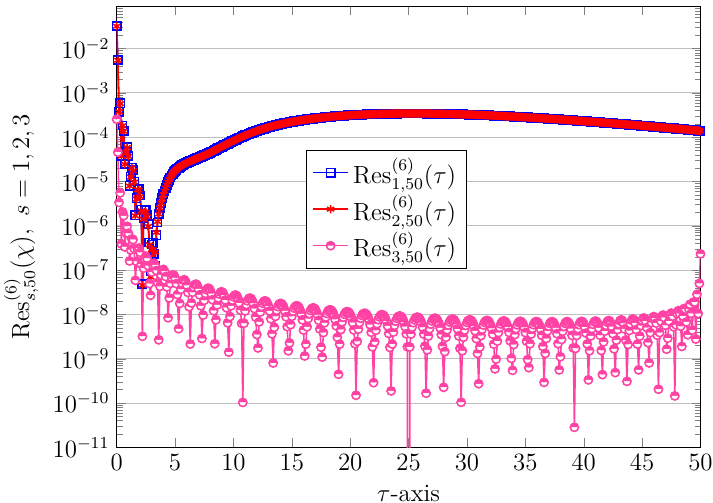
Figure 7. Graphics of achieved REFs via QLM-SMV in Test Case 2 with Q = 50.